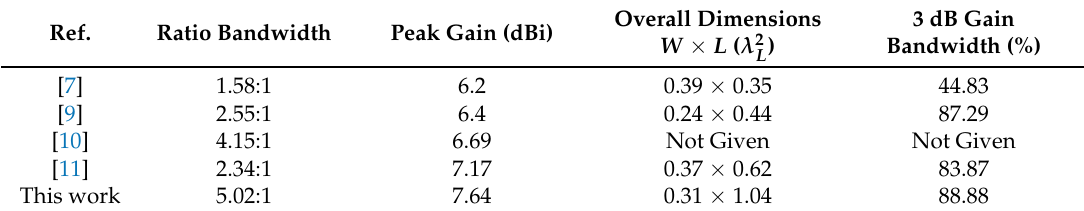
Table 2. Performance Comparison with Previous Miniaturized Log-Periodic Array Antennas.